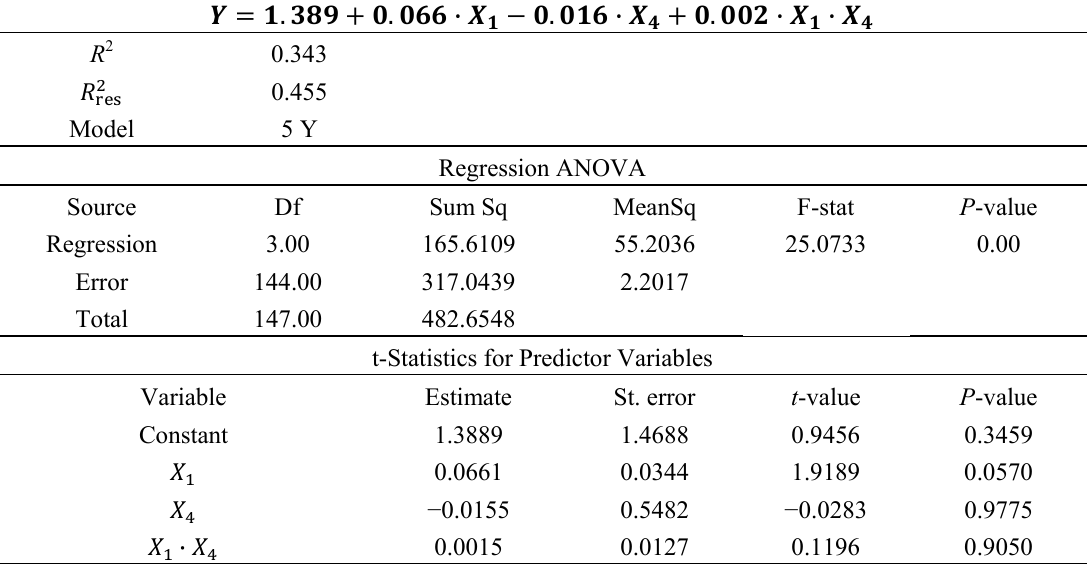
Table 7. ANOVA results for Model 5Y of Table